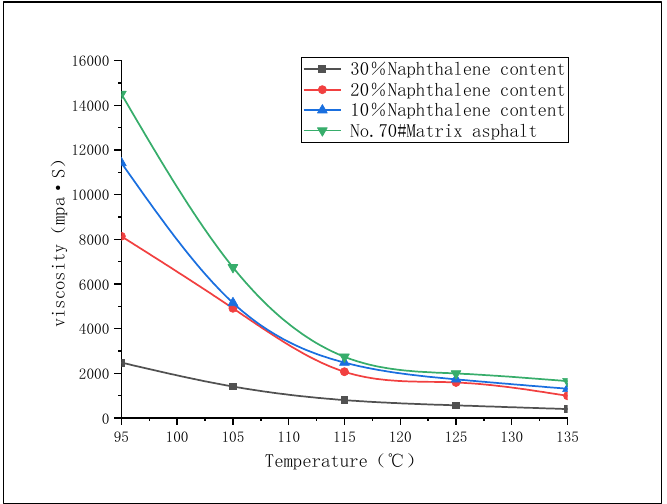
Figure 1. Viscosity curve of asphalt with different naphthalene content.